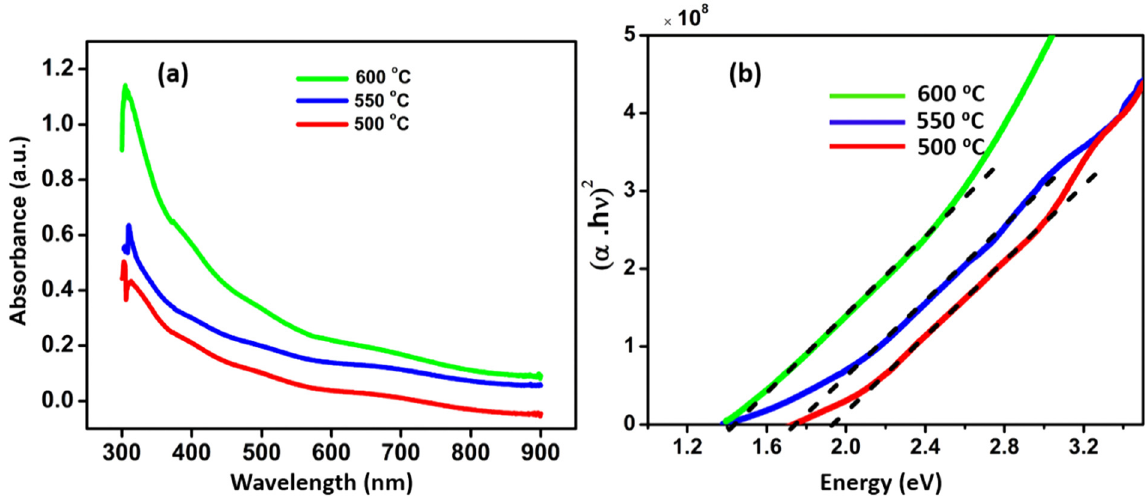
Figure 5: ( a ) UV - Vis absorption spectra and ( b ) optical band gaps of Tl 2 S thin fi lms fabricated at three di ff erent temperatures on the FTO substrate.